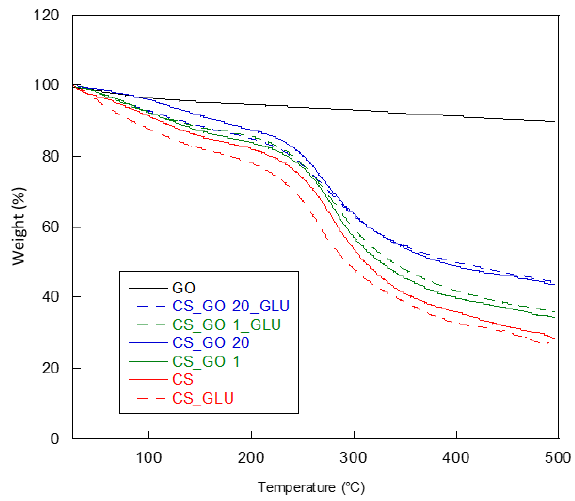
Figure 4. Thermogravimetric curves of pristine CS, GO, and CS_GOX composites before and after the crosslinking reaction.